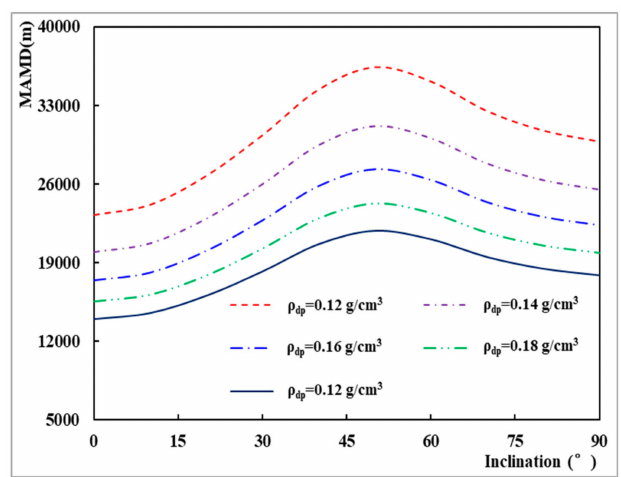
Figure 15. Effect of bottom hole inclination on the